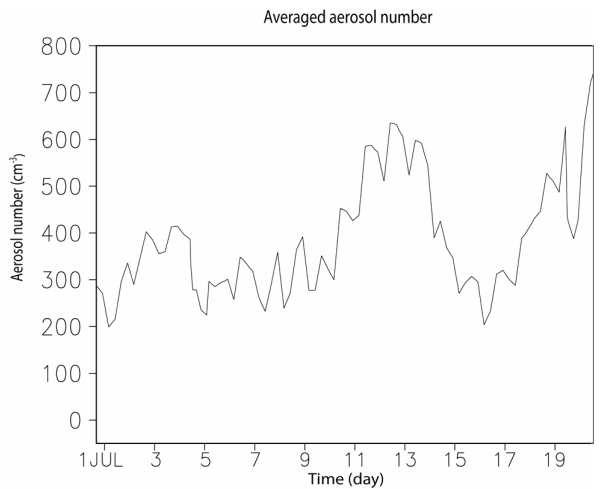
Fig. 4. Time series of background aerosol number concentration (cm − 3 ) averaged over the MBL in the CSRM